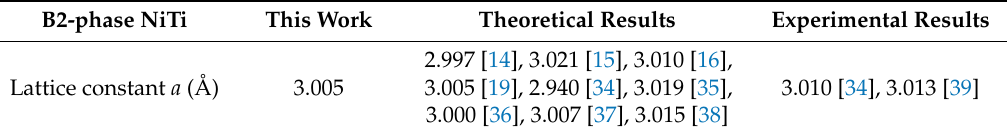
Table 2. Comparisons of the equilibrium lattice constant of this work to the other theoretical and experimental results for the B2-phase NiTi SMA.